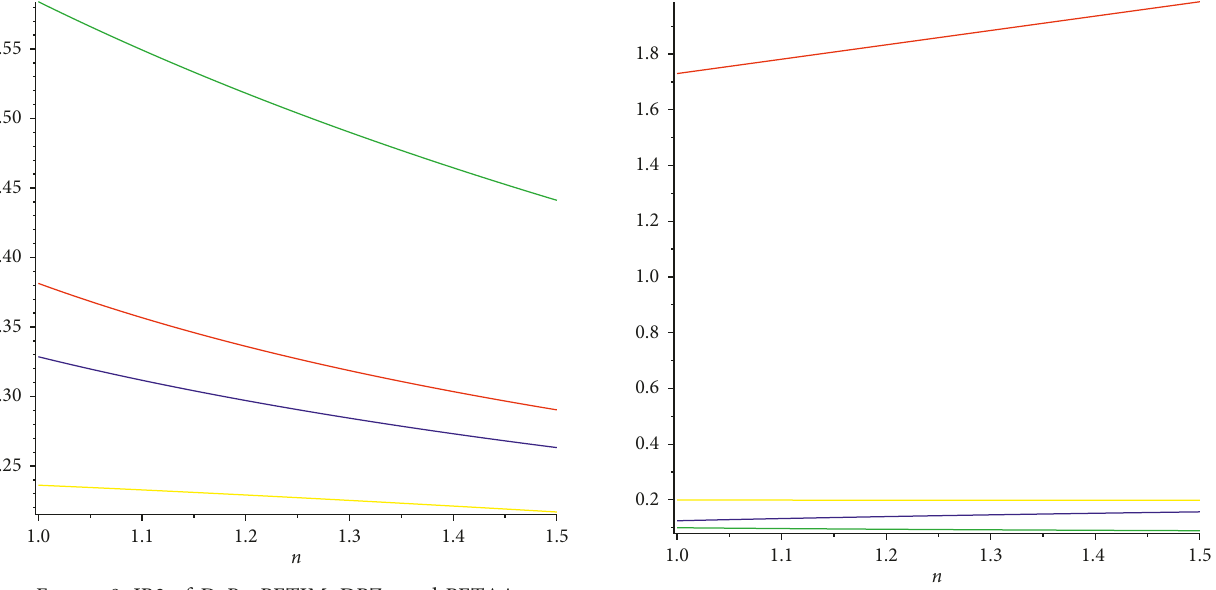
Figure 10: IRFW of D